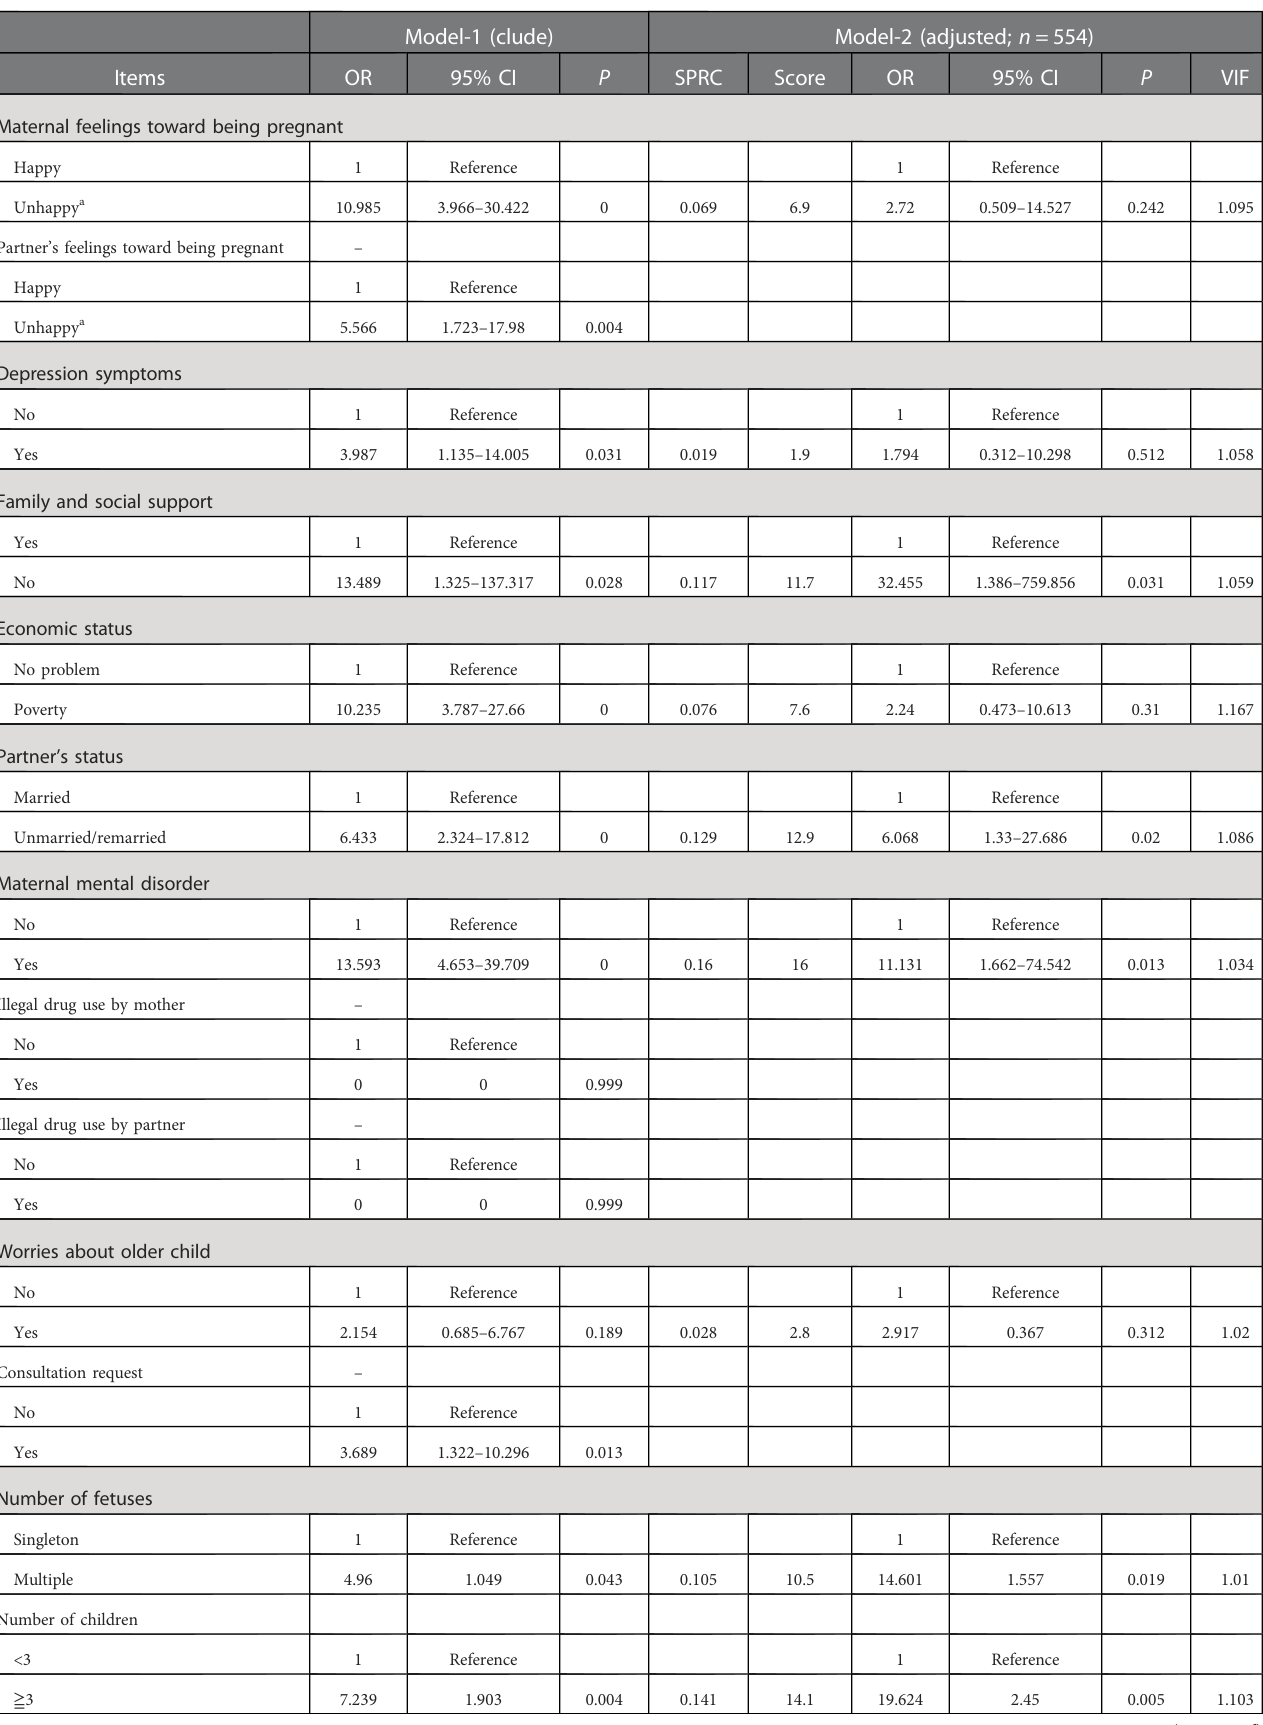
TABLE 3 The multiple linear regression analysis at fi rst